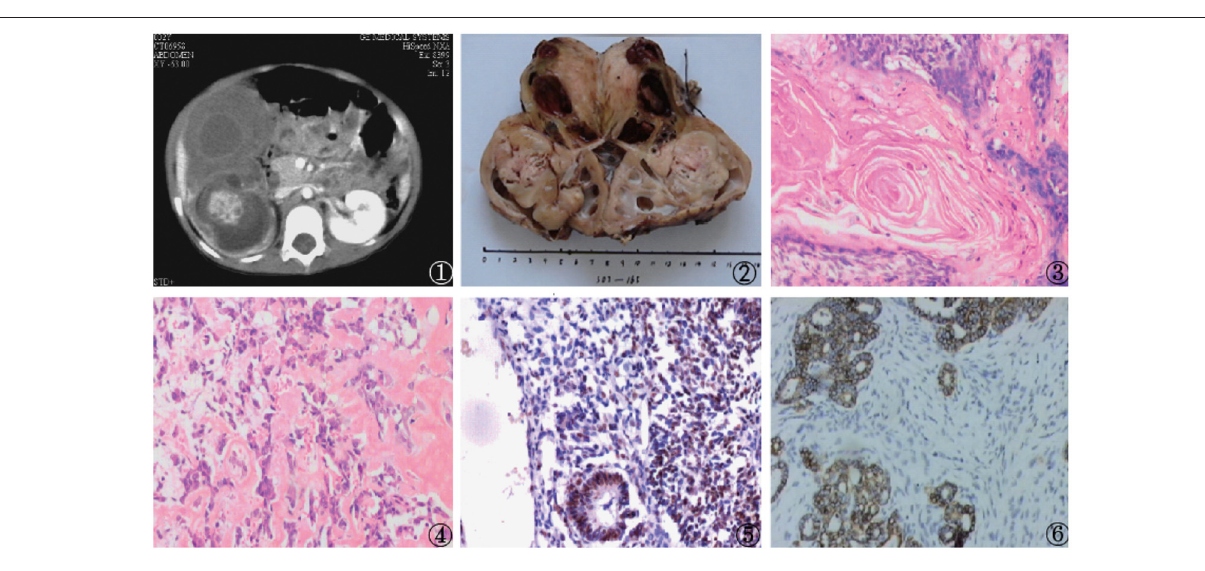
FIGURE 2 | Findings from a 20-month-old girl with a right renal tumor presenting to our hospital with a background of anemia. (1) Abdominal CT scan exhibiting a large mass that had almost fully replaced the right kidney; Nephrectomy samples demonstrating the large mass that had replaced the kidney; (3–5) Histologic examination of the mass revealed a heterologous epithelium with squamous epithelial, adipose, and calcified bead characteristics (H and E, original magnification × 40); (6) Positive WT-1 immunostaining in intratumoral